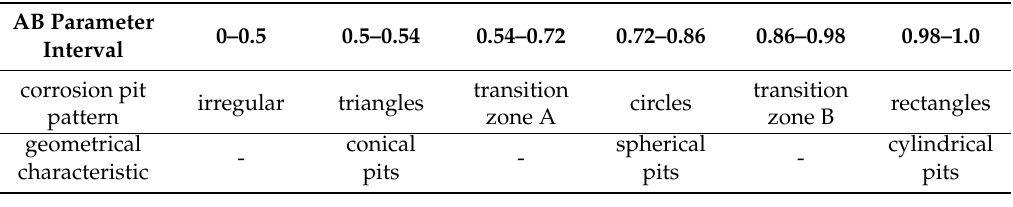
MD, USA) was used. Table 3. The corresponding area-box (AB) parameter for pit pattern with different geometrical characteristics. Table 3. The corresponding area ‐ box (AB) parameter for pit pattern with different geometrical characteristics.